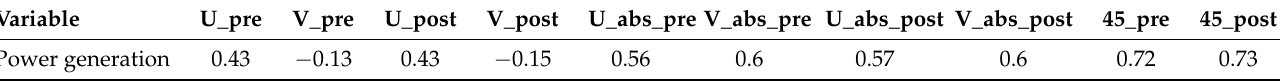
Table 4. Pearson’s correlation coefficient with power generation by time